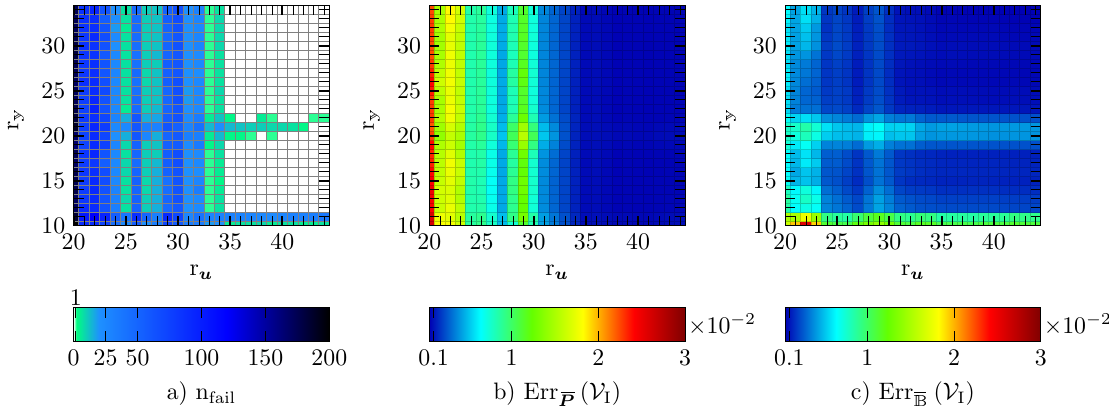
Figure 6. ( a ) robustness and ( b , c ) output error analysis for varying numbers of residuum modes r u and r y for sufficiently large numbers of gappy points p u = basis of size n u = 20 and n y =